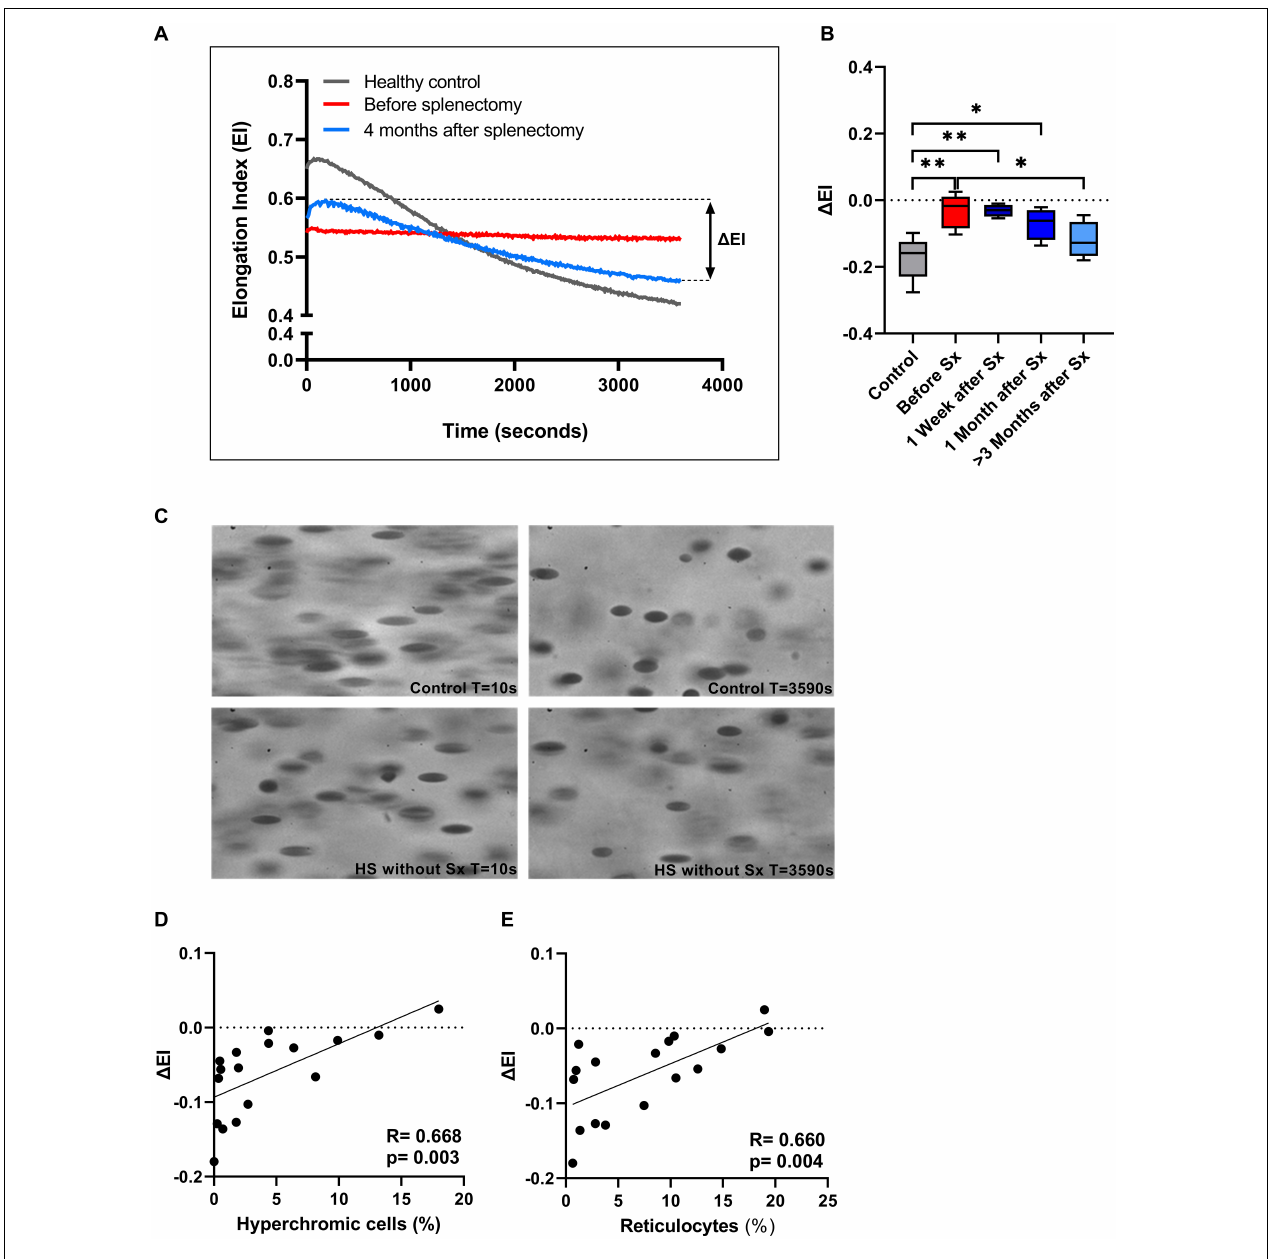
FIGURE 3 | The Cell membrane stability test (CMST) and the calculated parameter ( (cid:49) EI) improves after splenectomy in a longitudinal study of 5 HS patients. (A) Representative example of the CMST before (red line) and 4 months after splenectomy (light blue line) compared to a healthy control (dark gray line). (B) The mean values of (cid:49) EI of HS patients ( n = 5) before and after splenectomy. (C) Microscopic images of the RBCs in the Lorrca during a CMST. Start of the measurement ( T = 10 s) compared to the end of the measurement ( T = 3,590 s) in a control and HS patient without splenectomy. (D) Correlation between (cid:49) EI and hyperchromic red blood cells. (E) Correlation between (cid:49) EI and reticulocytes (%). Error bars represent standard deviation. ** p < 0.01, * p ≤ 0.05. Sx, splenectomy; HS, hereditary spherocytosis; T, time; s,